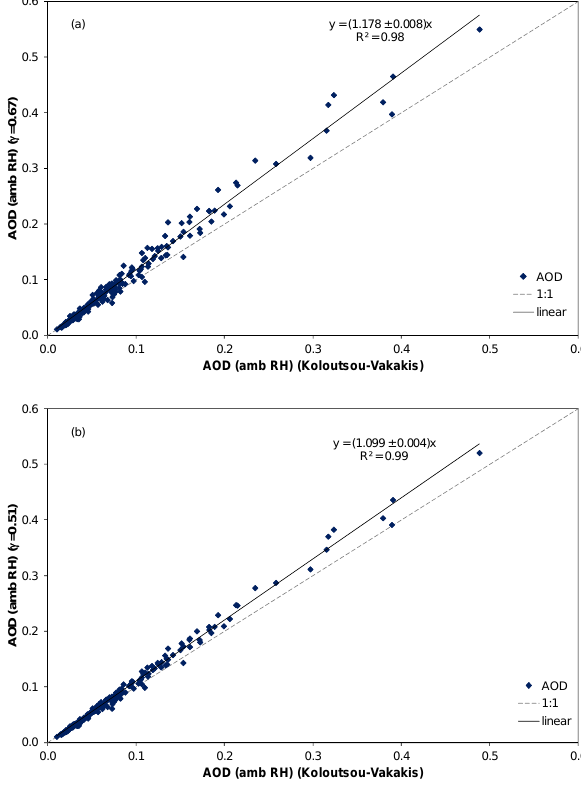
Fig. 9. Comparison of AAO aircraft calculated AOD adjusted to ambient RH using (a) Quinn et al. (2005) parameterization ( γ =0.67) and (b) AAO f (RH) analysis ( γ =0.51) with AAO AOD adjusted to ambient RH using Koloutsou-Vakakis et al. (2001) pa- rameterization ( γ =0.33) (at